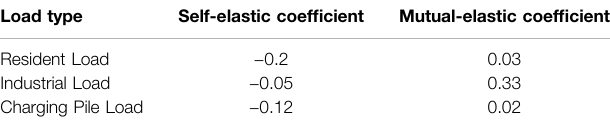
TABLE 3 | Differential elastic coef fi cients of three types of load.